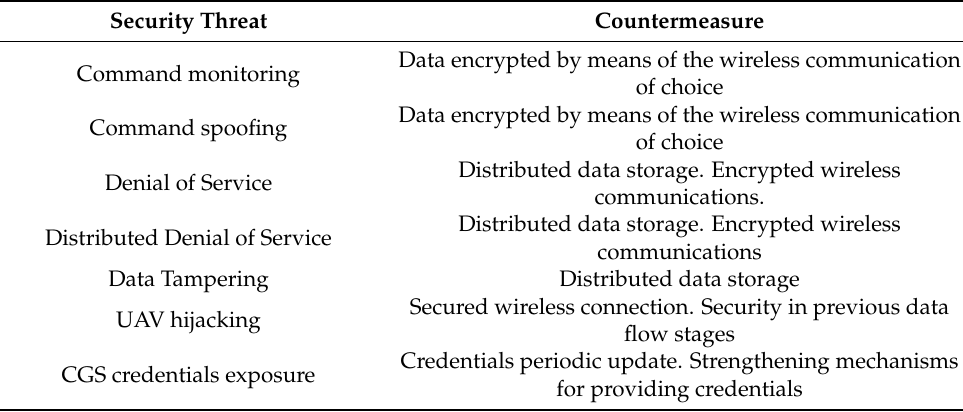
Table 7. Security threats in the system and how to counter